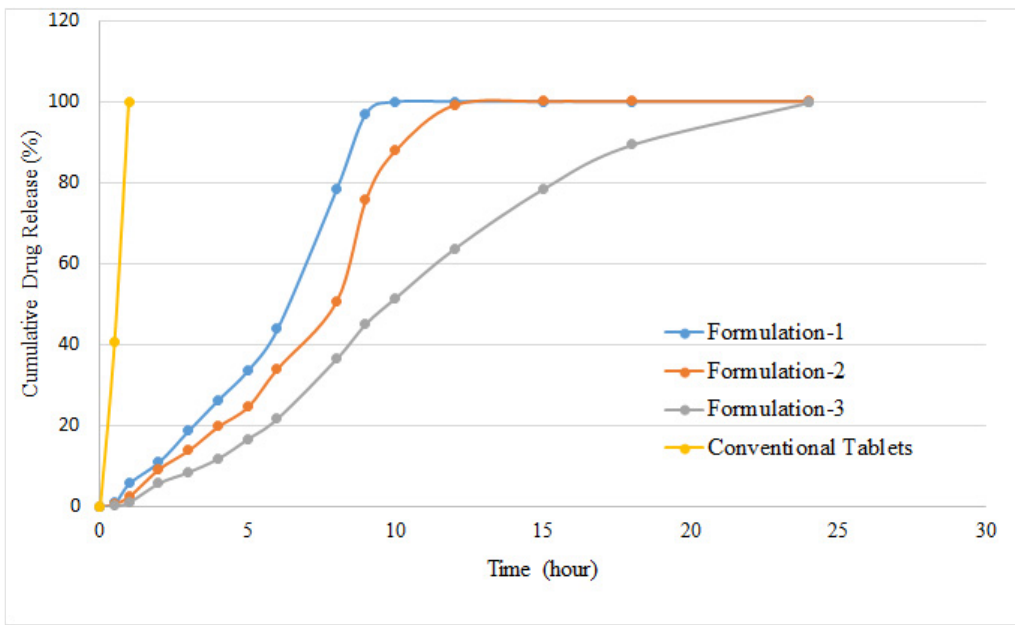
Figure 3. In vitro drug release from controlled ‐ release tablets and conventional tablets of clarithro ‐ mycin.